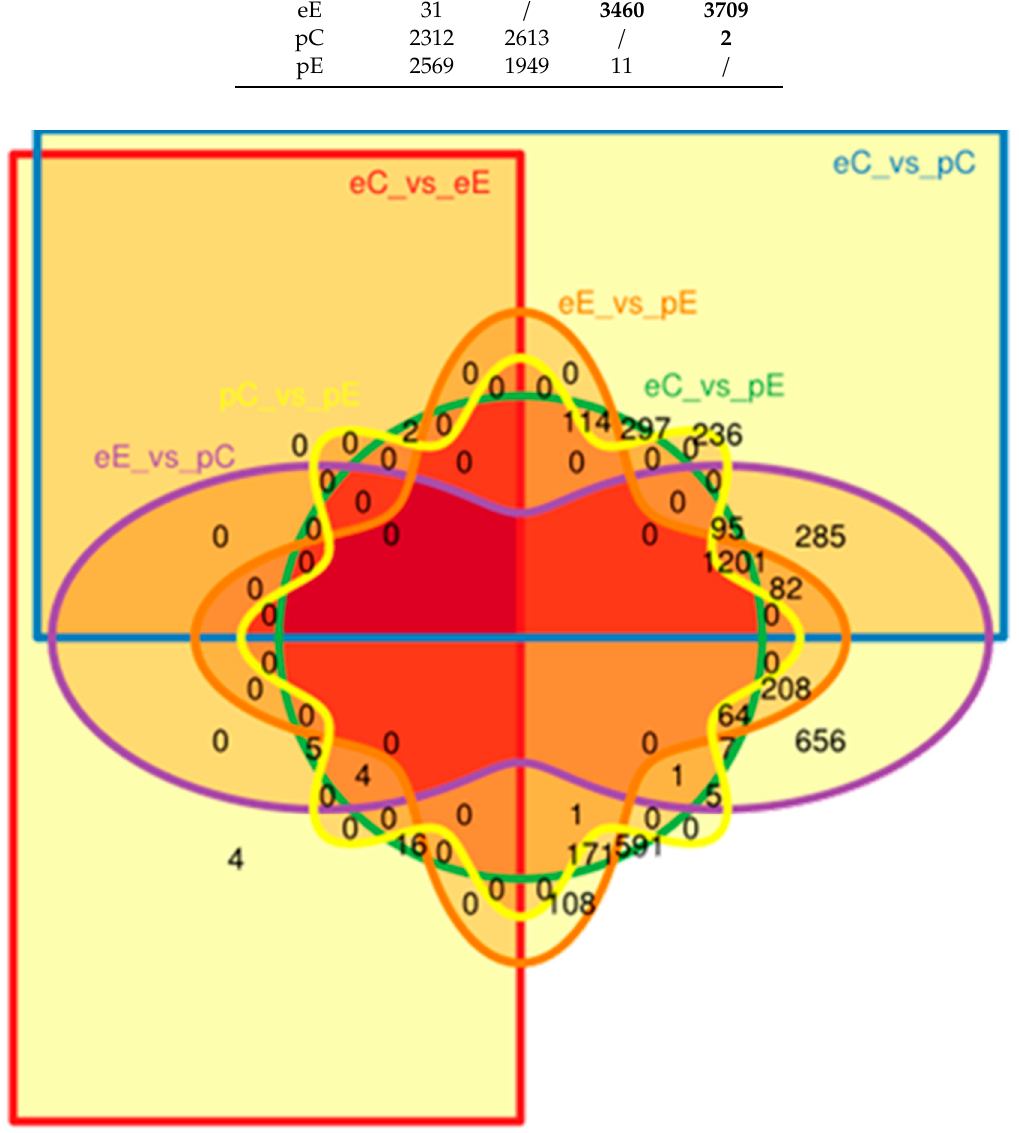
Figure 5. Venn diagram of edegR data showing the intersections between the differentially expressed genes from Q. pubescens : eC_vs._eE; eE_vs._pE; eC_vs._pC; pC_vs._pE; eE_vs._pC and eC_vs._pC. Control plot in summer, eC; rain exclusion plot in summer, eE; control plot in spring pC and rain exclusion plot in spring, pE. Table 4. Differentially expressed genes (DEG) of Q. pubescens leaves in response to the sampling season and the rain exclusion treatment . The thresholds of statistical tests were fixed at p adj < 10 − 3 and according to the log2FC ≥ 2. 5724, and 4153 DEG were detected by DESeq2 (bold) and edgeR, respectively; e and p denote sampling in summer and spring, respectively; C and E denote control and rain exclusion treatments, respectively.